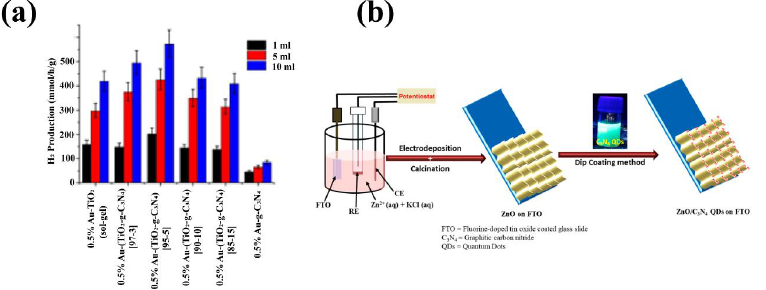
Figure 17. ( a ) Hydrogen production rate of different samples as a function of the amount of methanol added as a sacrificial agent under solar light irradiation, Reproduced from Reference [403]; ( b ) schematic image of the ZnO/C 3 N 4 QDs synthesis on FTO using electrodeposition and a dip-coating method, Copyright © 2022 Elsevier [406].